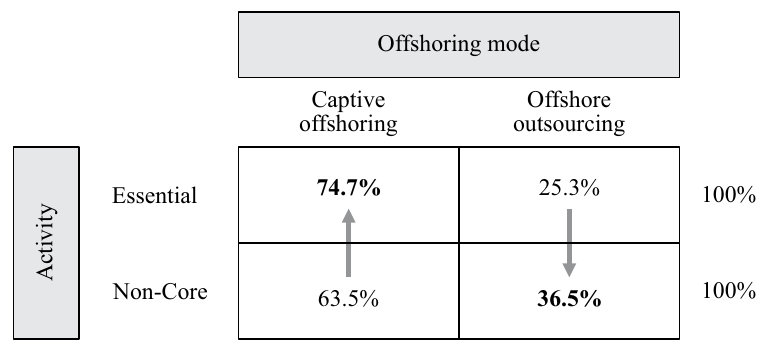
Table 3. Share of activity by offshoring mode